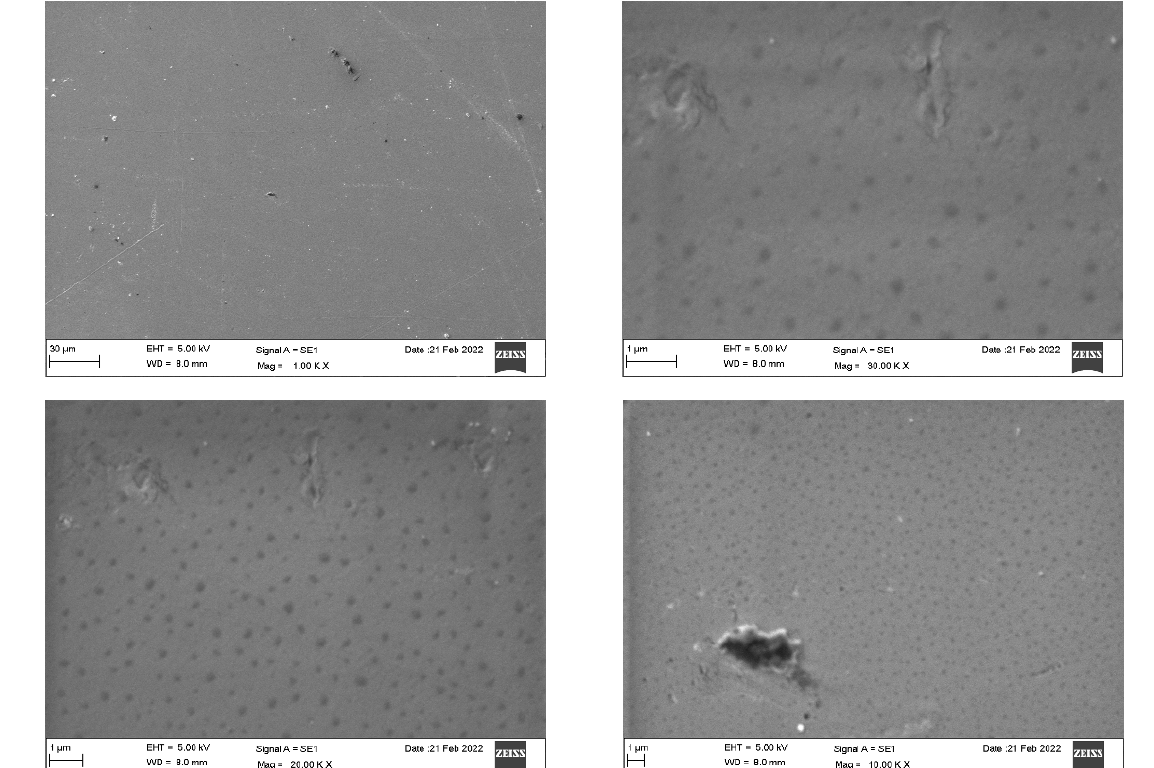
Figure 5 . Scanning electron microscopy of the SureSmile ® system .